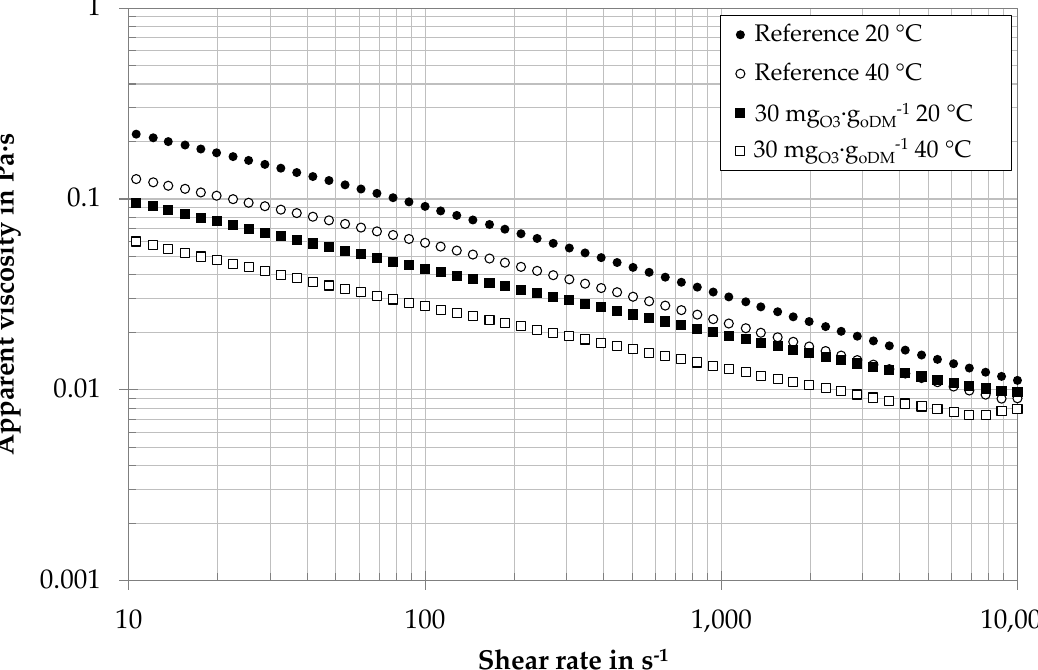
Figure 5. Viscosity curve (each curve average of three different days, Anton Paar MCR 101) of digestate centrate of an agricultural biogas plant with ozone treatment and without (reference).